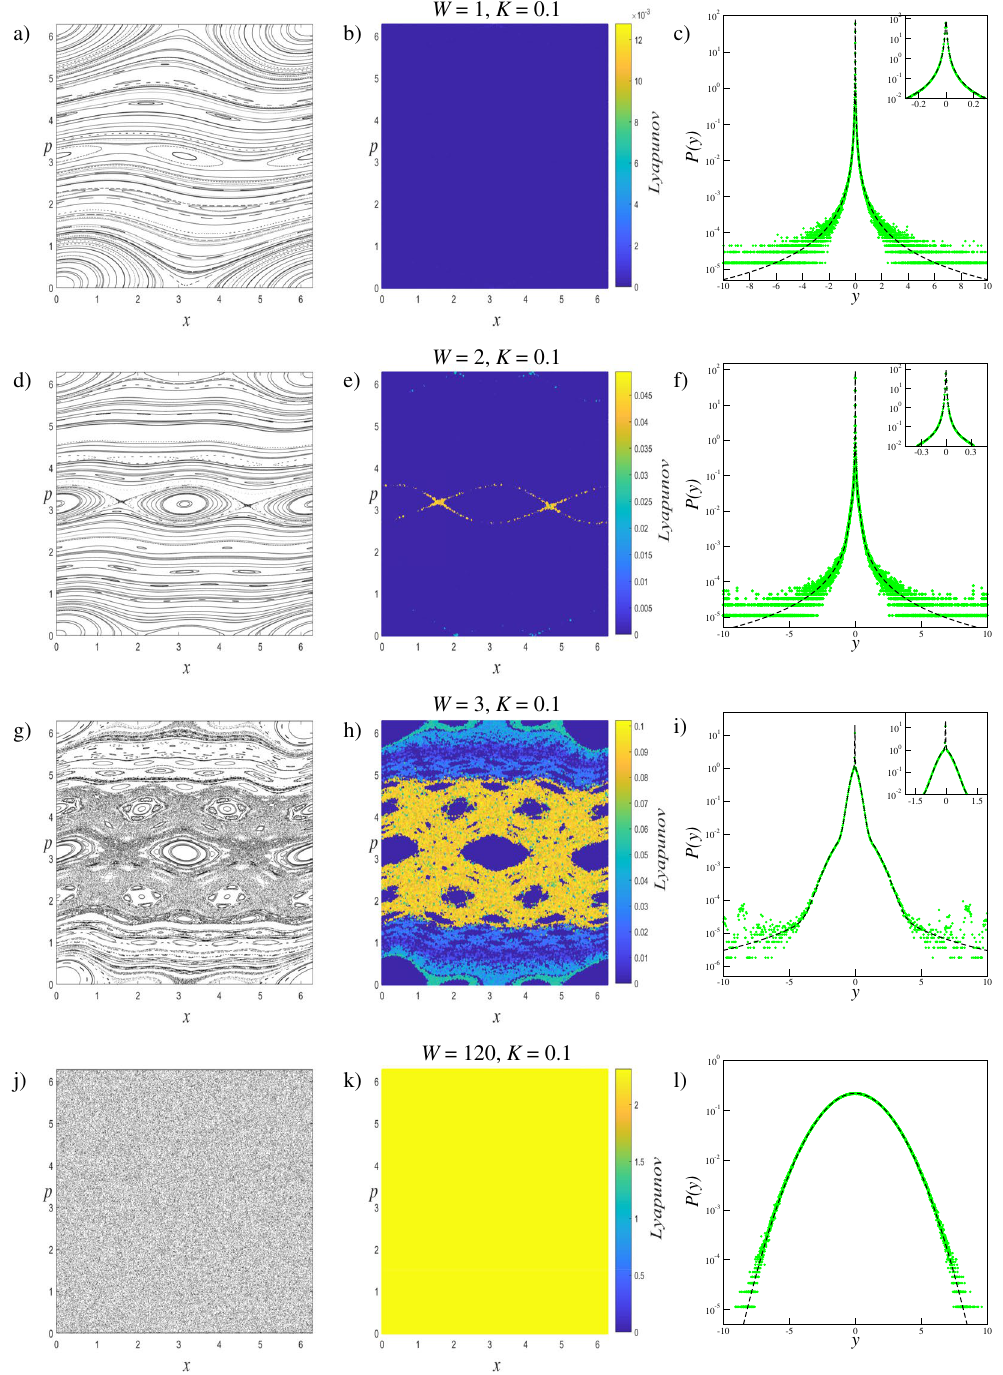
Figure 2. Analyses of the W = 1 , W = 2 , W = 3 , and W = 120 systems for K = 0.1 . Left column: ( a , d , g , j ) Phase space portraits, Middle column: ( b , e , h , k ) LLE color map descriptions of the phase portraits, Right column: ( c , f , i , l ) Probability distributions obtained from the initial conditions chosen from the entire phase